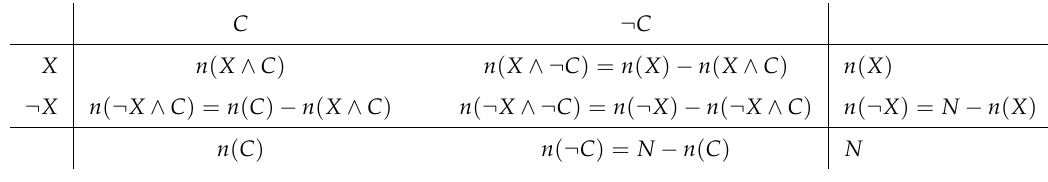
Figure 2. Contingency table for a class association pattern X ∧ C